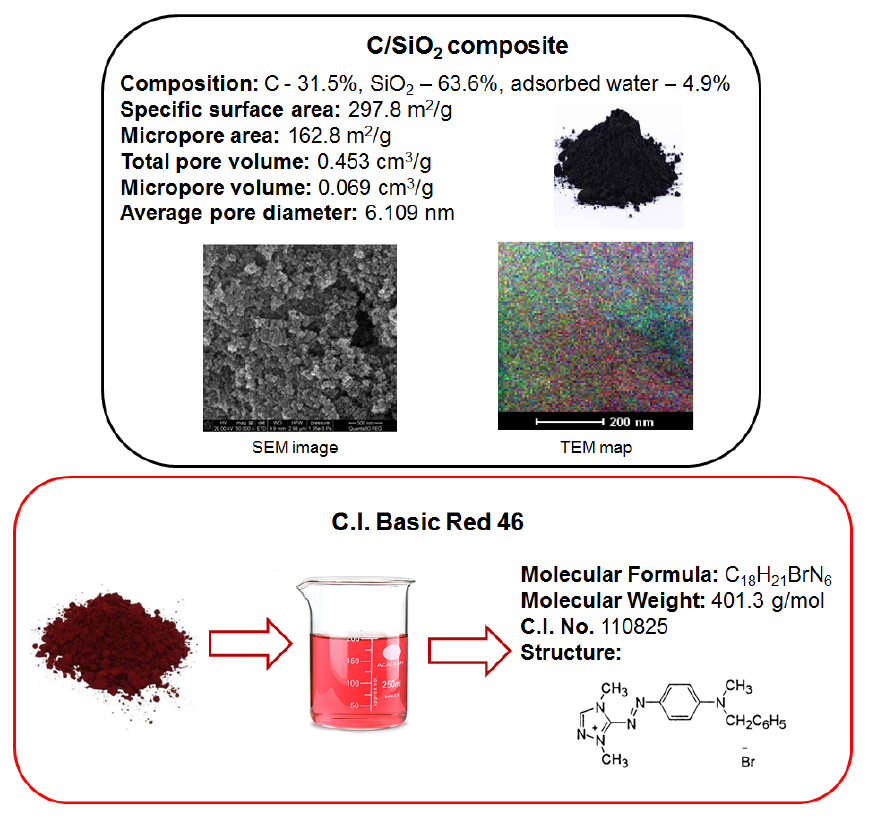
Figure 7. C.I. Basic Red 46 properties.